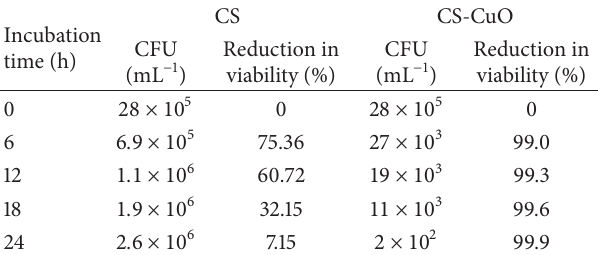
Table 1: Antibacterial activity of CS-CuO hybrid against E. coli